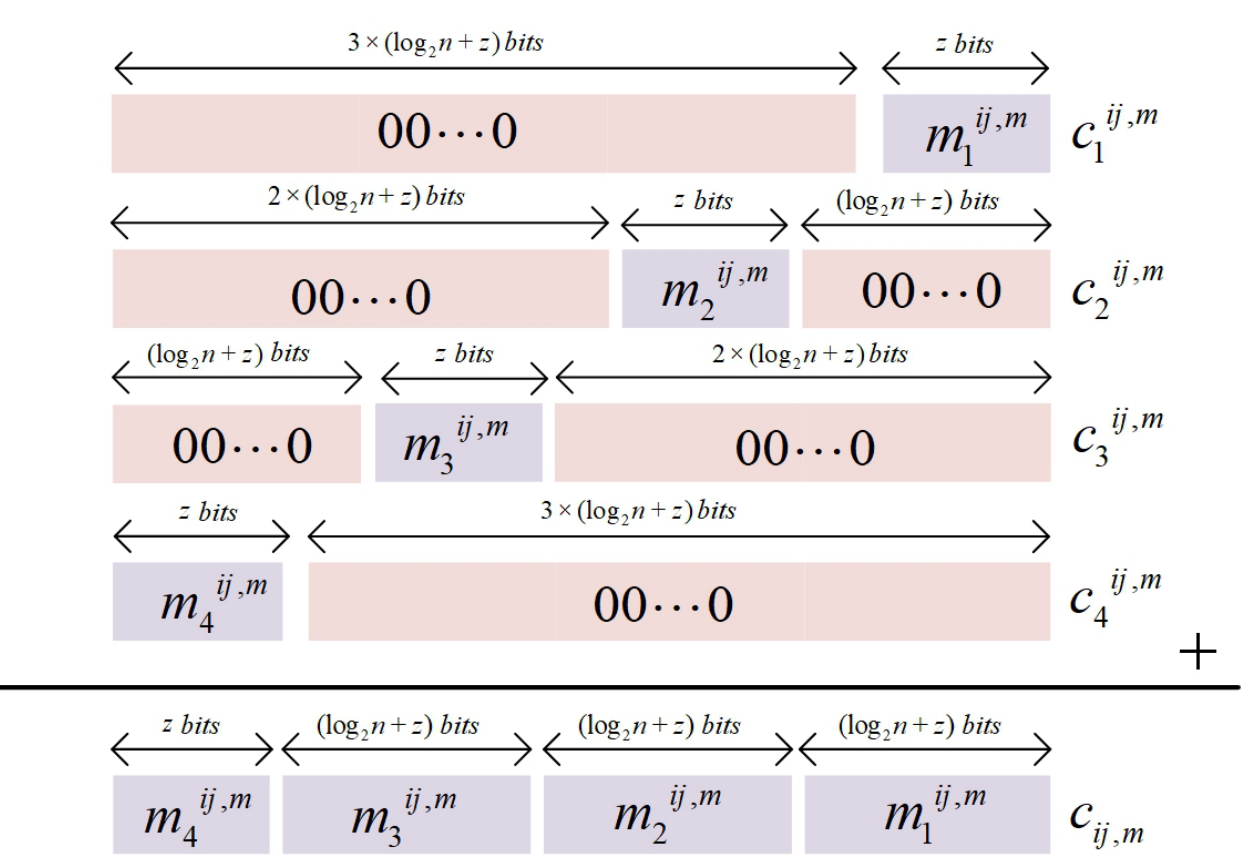
Figure 3. The detailed form of c ij , m ( l =